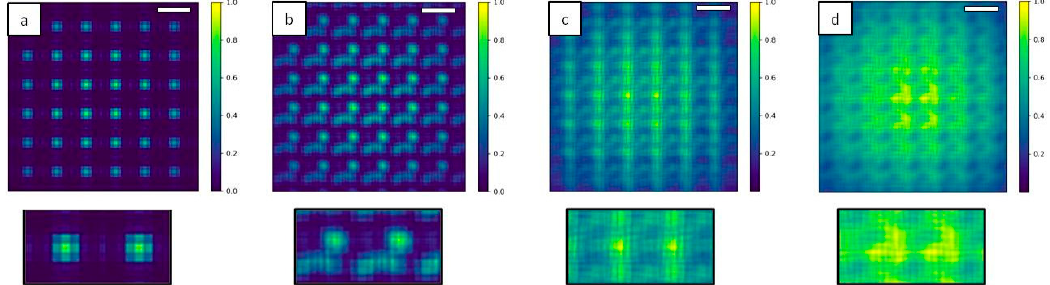
Figure 10. 2D intensity map of the Hartmann mask at the Talbot plane increasing N. For N = 1 ( a ) the square pattern of the mask is exactly reproduced, while for N = 10 ( b ) and for N = 100 ( c ) the image is blurred. In the incoherent case N = 1000 ( d ) the square shape is completely lost. Insets show a magnification of the central part of the mask. Scale bars are 15 µ m.